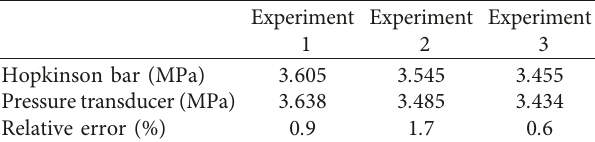
Figure 10: Pressure-time profiles obtained by Hopkinson bar and pressure transducer of the other two experiments. Table 3: The relative errors between peak pressure obtained by the Hopkinson bar and the pressure transducer of these three same